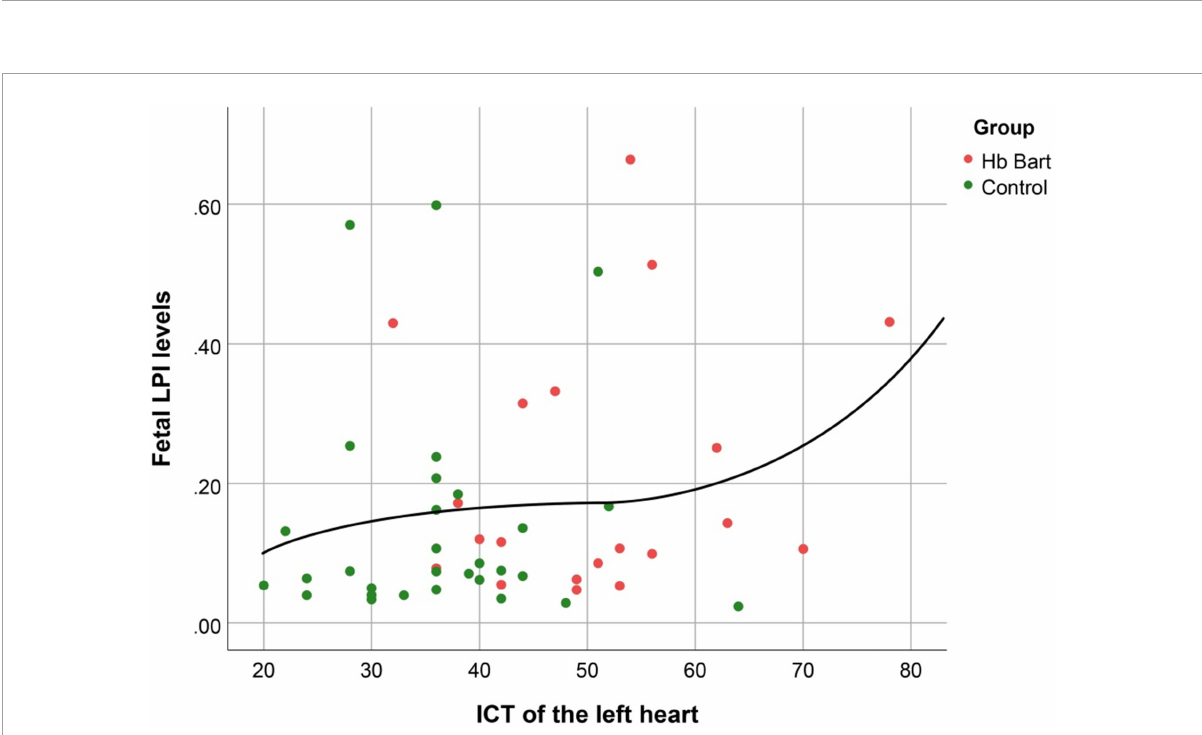
FIGURE6 The correlation between fetal LPI (Labile Plasma Iron) levels and fetal left isovolumetric contraction times (ICT) (Cubic function; R 2 : 0.044; p :